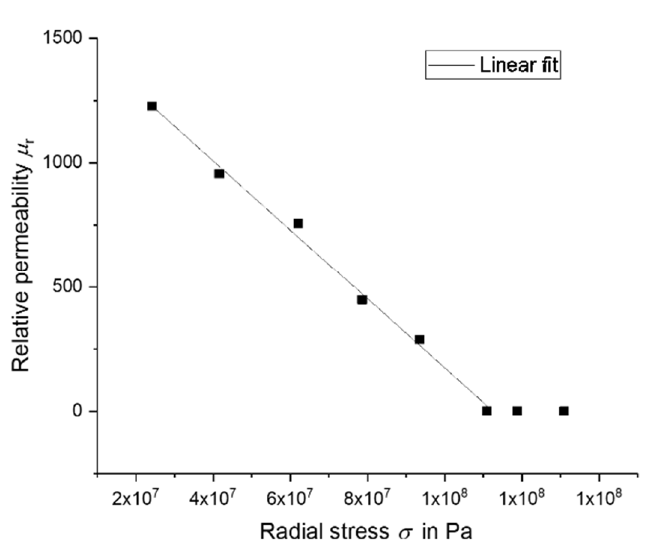
Figure 11. Relationship between relative magnetic permeability of the FeSiB and the radial stress in the diaphragm caused by deformation.